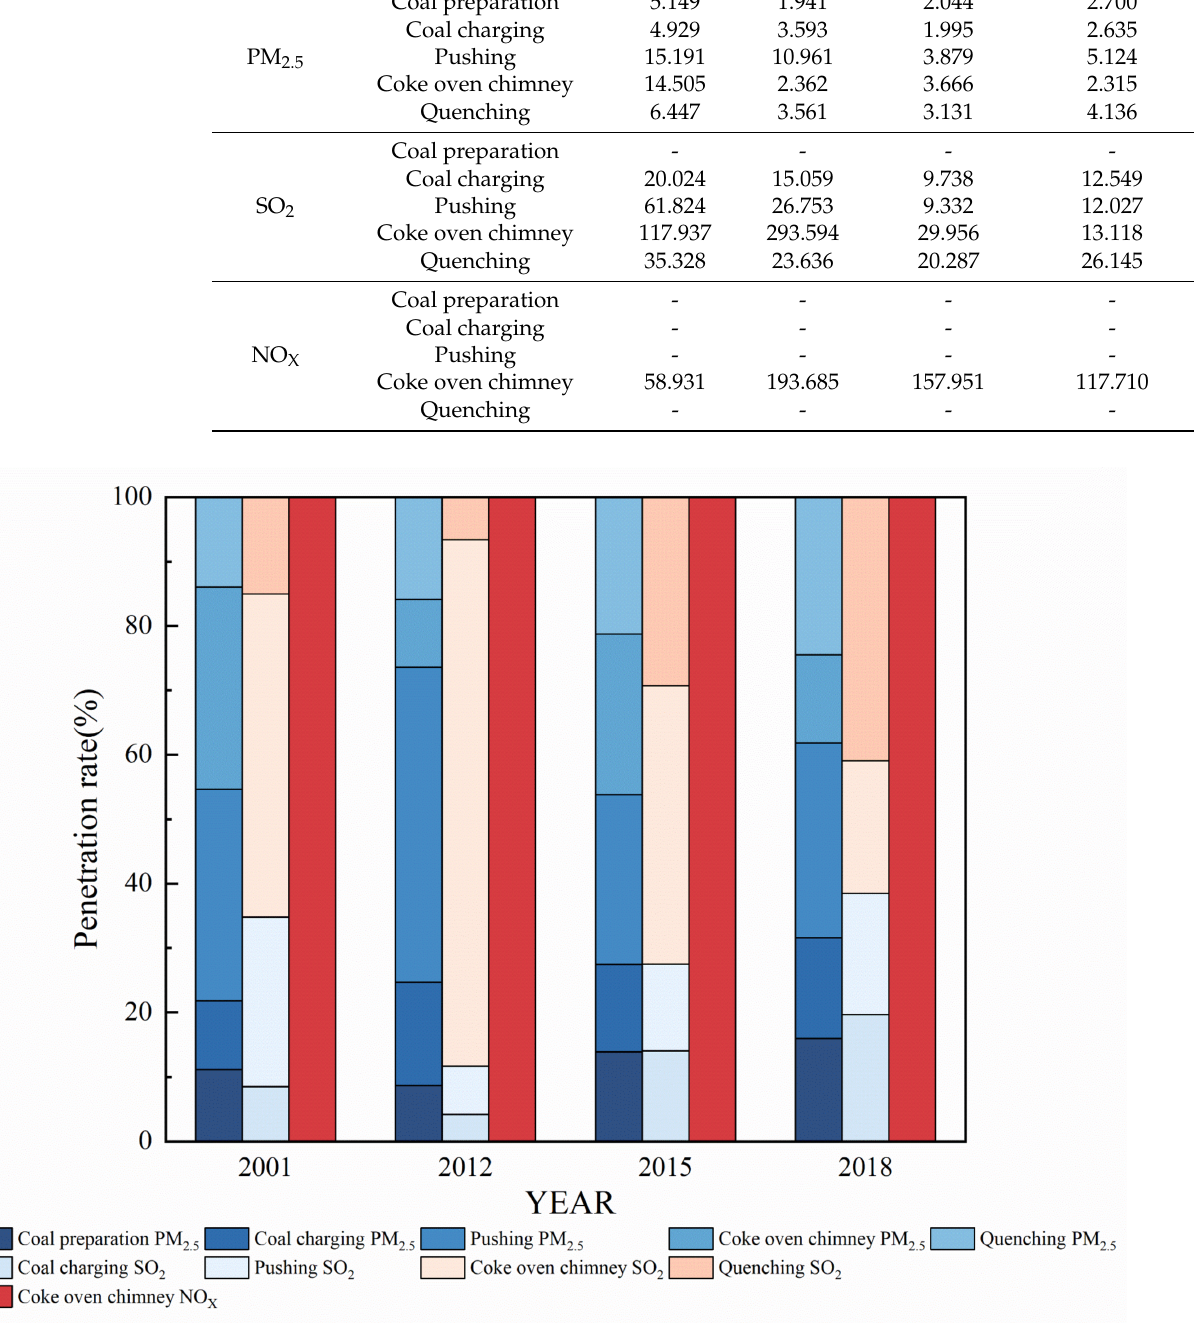
Figure 5. Contributions of emissions from different components of the procedures conducted by China’s independent coking industry in 2001, 2012, 2015, and